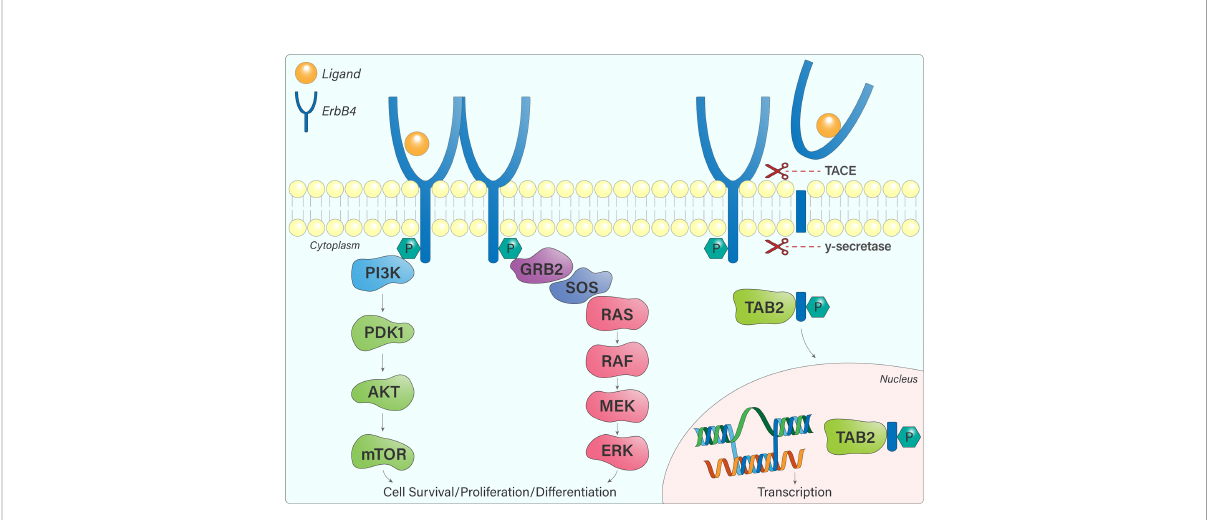
FIGURE 4 ErbB4 signalling pathways. Once ErbB4 is phosphorylated, signalling cascades become activated, notably the PI3K-AKT and Ras-MAPK pathways that in fl uence cell survival, proliferation, and differentiation. JM-a or JM-d-containing ErbB4 variants are cleaved by TACE and g -secretase, resulting in the release of a soluble intracellular fragment that forms a complex with TAB2 and undergoes nuclear translocation. In the nucleus, ErbB4 regulates gene